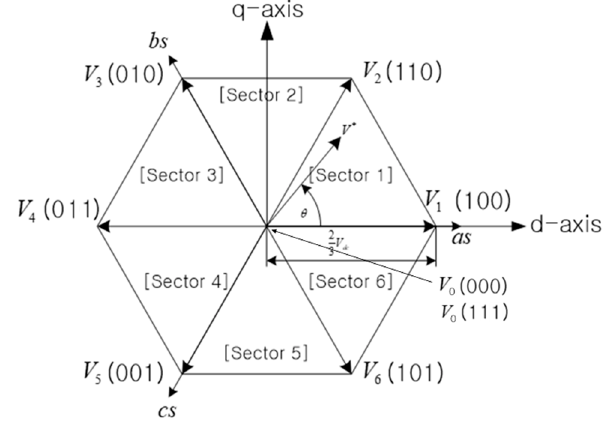
Figure 2. Switching states of the SVPWM technique.